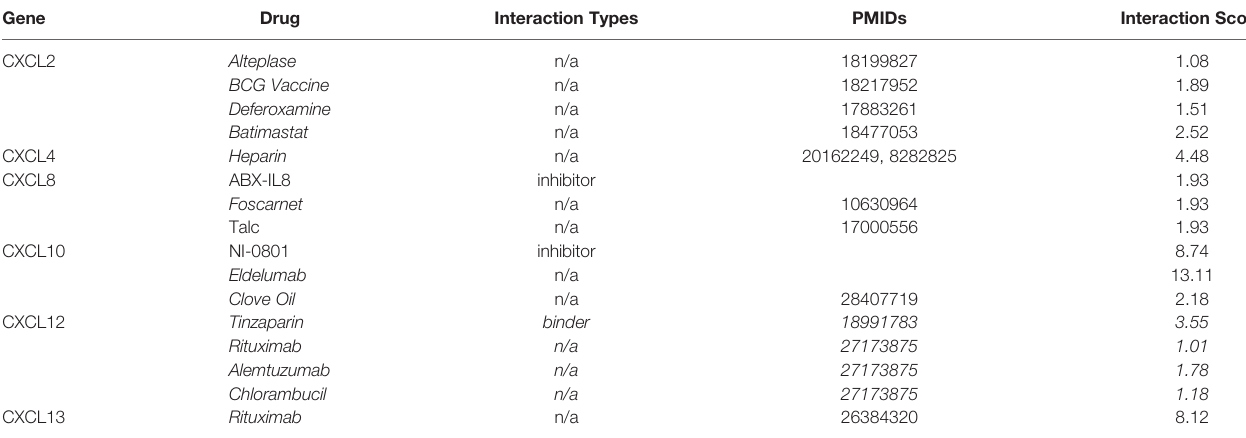
TABLE 5 | The drug gene interactions or potentially available drug categories for PAAD patients with abnormal expression CXC chemokines